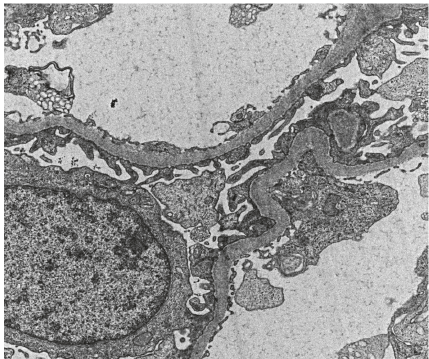
Figure 4: Electron micrograph showing glomerular capillaries with well-preserved foot processes of visceral epithelial cells (uranyl acetate and lead citrate X